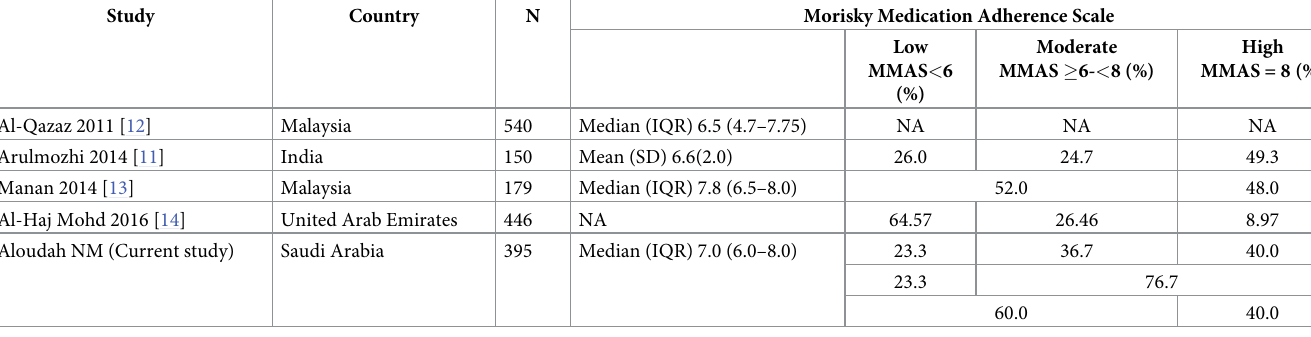
Table 4. Cross-country comparison of prevalence of medication adherence using